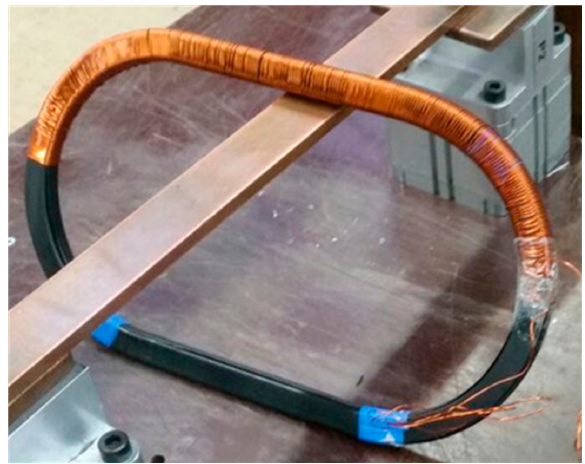
Figure 1. Current transformer core with partially distributed secondary winding.